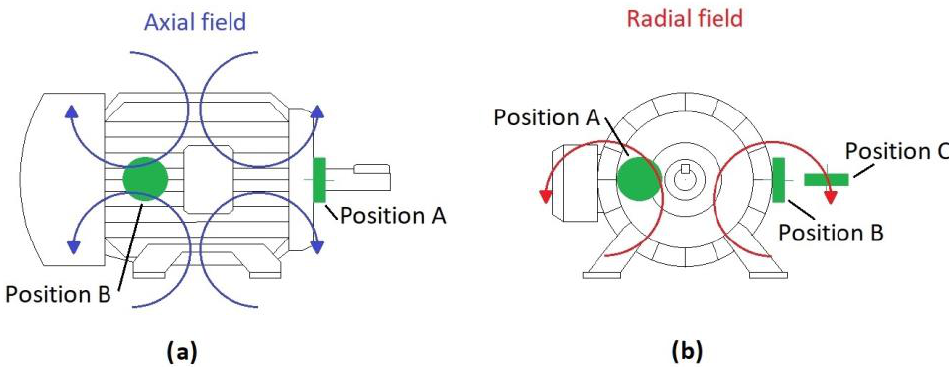
Figure 1. Flux sensor positions and stray-flux components: ( a ) axial field; ( b ) radial field.